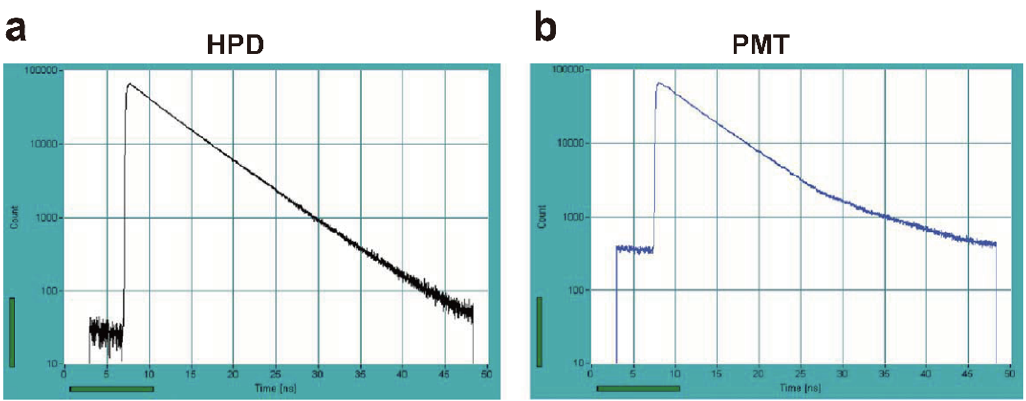
Figure 11. Fluorescence lifetime measurement data obtained by an HPD ( a ) and a PMT ( b ). The data were acquired using fluorescein dye solution. Adapted with permission from [13].